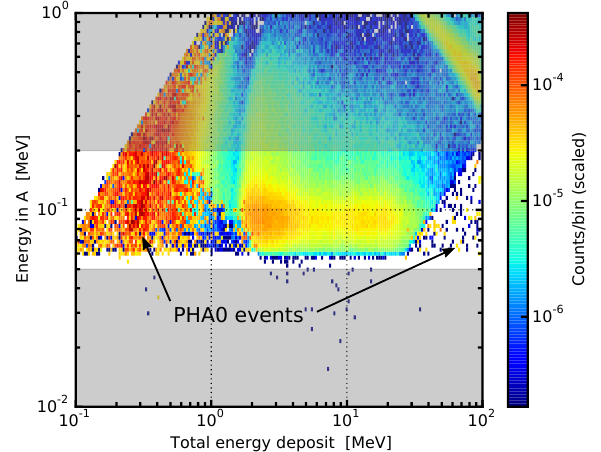
Figure 6. Simulated RAD measurement based on Planetocosmics calculation (compare Fig. 3) and RAD measurements for Sol 400– 500 (green) and RAD RTG background measurements (purple). Un- certainties in the simulated instrument behavior, caused by the not well known inefficiency of the AC, are marked as gray area. The individual contribution of simulated electrons, positrons and muons are shown in blue, red and